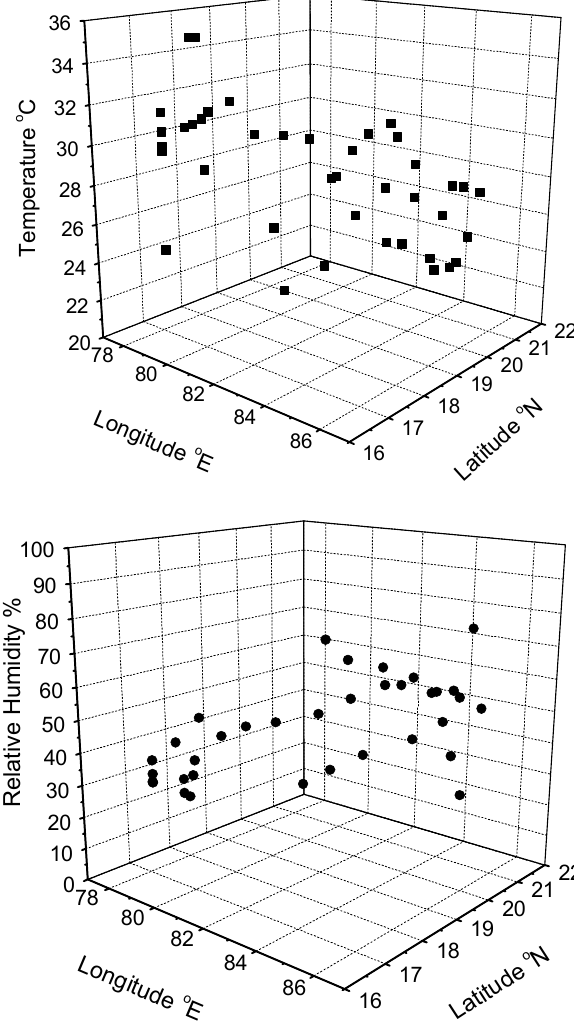
Fig. 2. Surface temperature (top panel) and humidity (bottom) at the observation